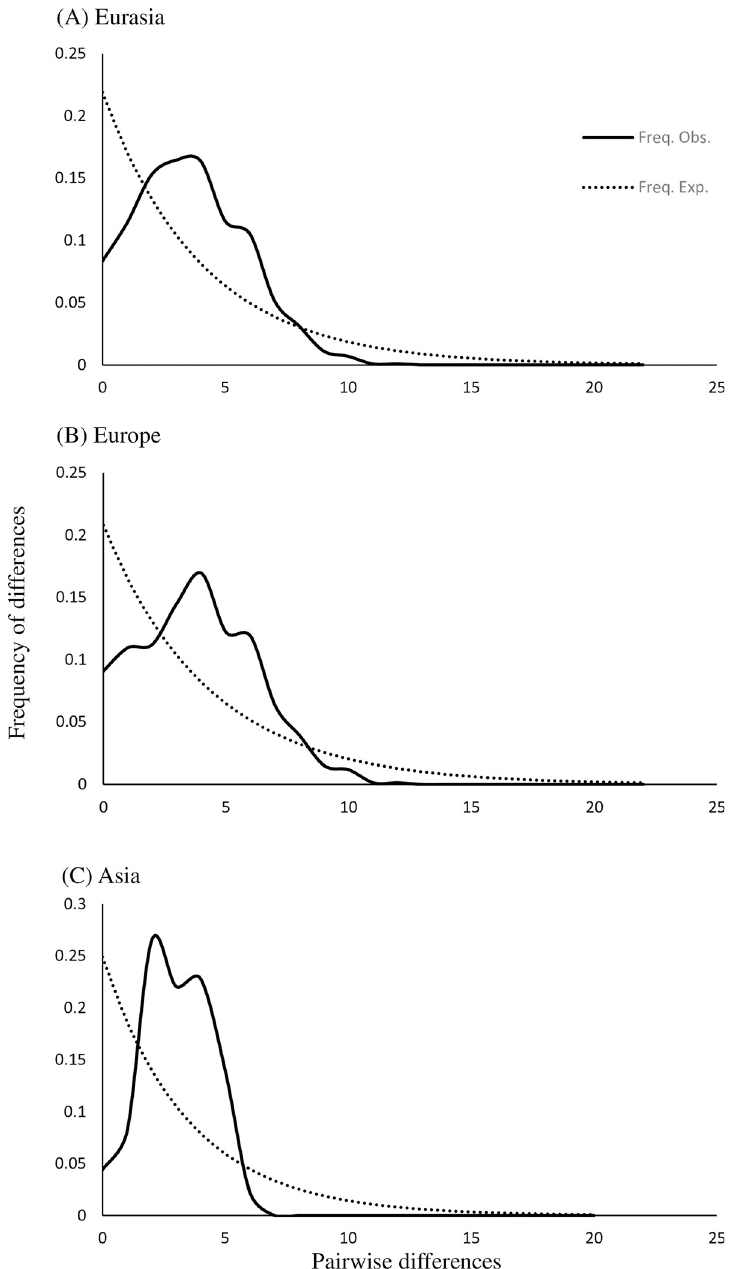
Fig 4. Mismatch distribution curves for nad 1 haplotypes of Echinostoma revolutum ( s . s .) isolates across Eurasia. ( A) Eurasia, combined data from Europe and Asia. (B) Isolates from Europe including those from England. (C) Asian isolates from Bangladesh and